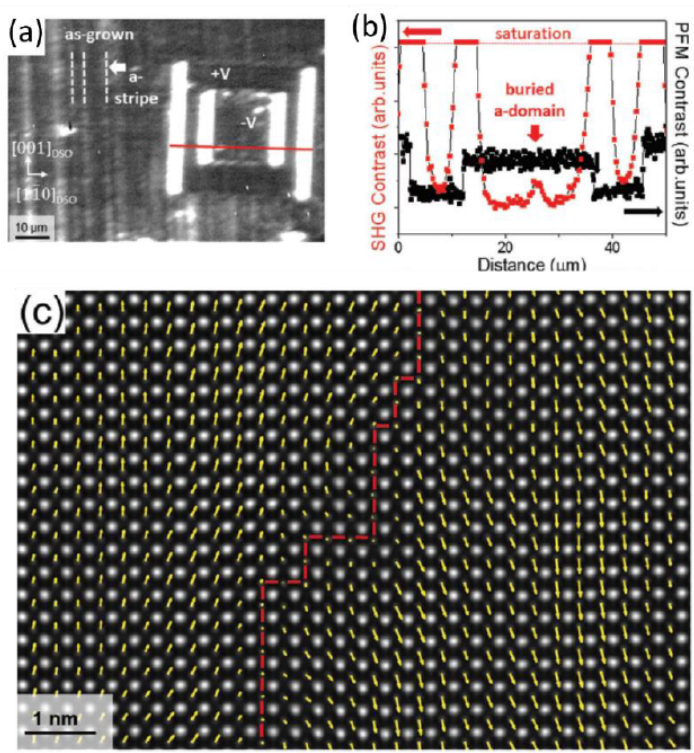
Figure 15. Polar behavior of a ferroelectric domain wall. ( a ) SHG imaging a stripe a -domain pattern in a PZT thin film. A tip-induced switching event is visible on the right side (+V and –V indicate where a positive and negative voltage was applied by the scanning tip, respectively). ( b ) Piezoresponse force microscopy and SHG intensity line scans over the section indicated by the red line in ( a ). ( c ) High-angle annular dark-field (HAADF) STEM image overlaid with polarization vectors showing a smooth N é el-like rotation combined with an Ising-like polarization decrease across the domain wall. Reproduced with permission from [97], Copyright Wiley-VCH Verlag GmbH and Co. KGaA,